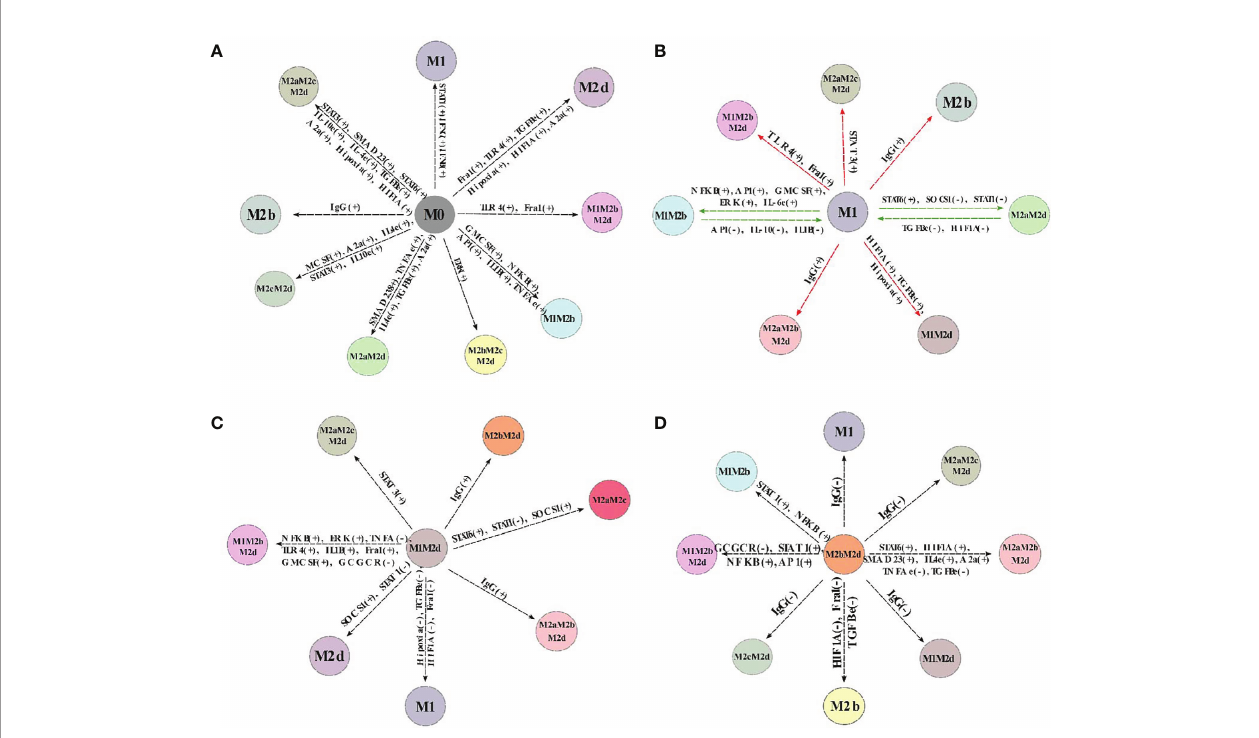
FIGURE 5 | Cell fate map of the macrophage polarization. Of all the attractors obtained, we changed the node ’ s value and maintained this perturbation until an attractor was reached. If the attractor ’ s transition to another phenotype, we represent it with a line and the new phenotype obtained by the perturbation. Plus sign (+) means the node was turned off, and we turn it on, while minus sign (-) means the perturbation was on, and we turned off. (A) Cell fate map of monocyte (M0). (B) Cell fate map of M1 macrophage. (C) Cell fate map of M1M2d macrophage. (D) Cell fate map of M2bM2d macrophage. Colors represent different states of macrophage